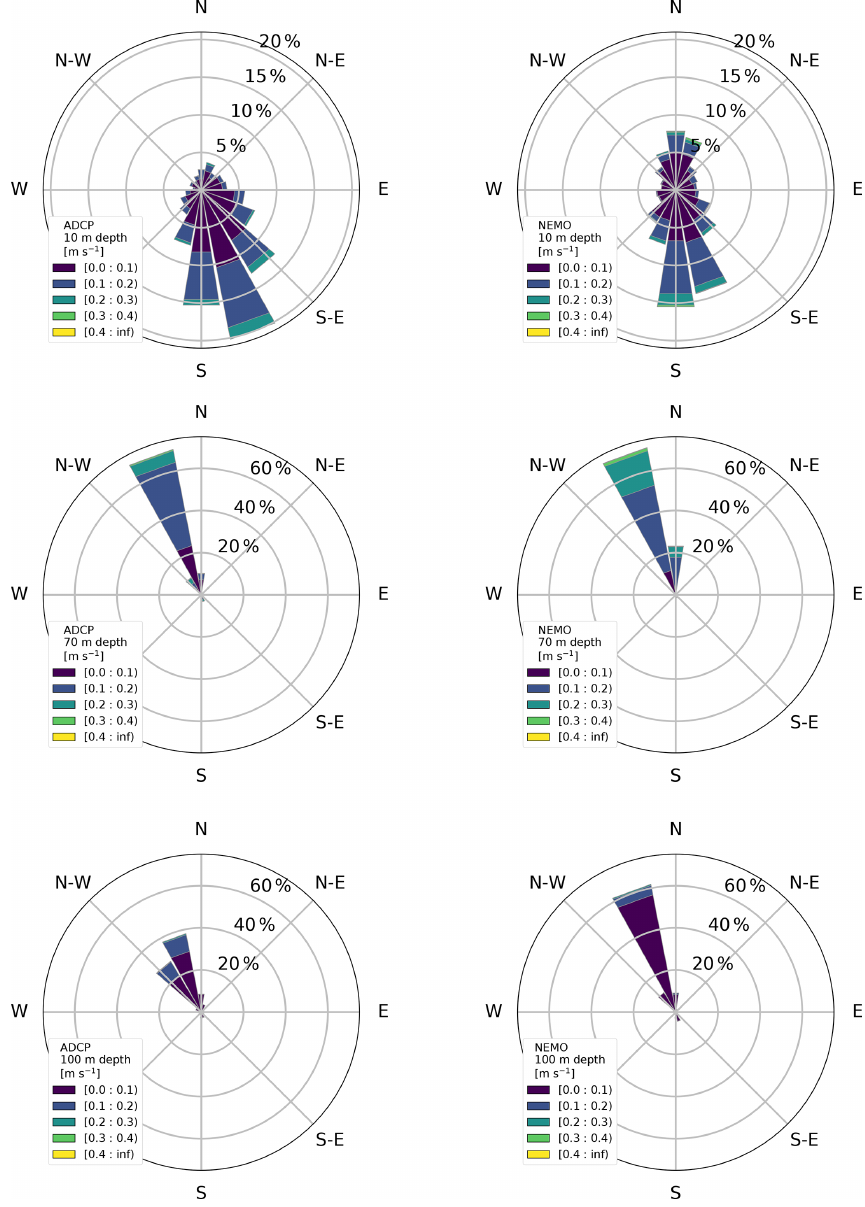
Figure 6. Comparison between measured and modelled currents at the ADCP location. Current roses are shown for 6 August 2016–28 December 2017 at depths of 10, 70 and 100m. Please note that current roses indicate the direction where the currents flow